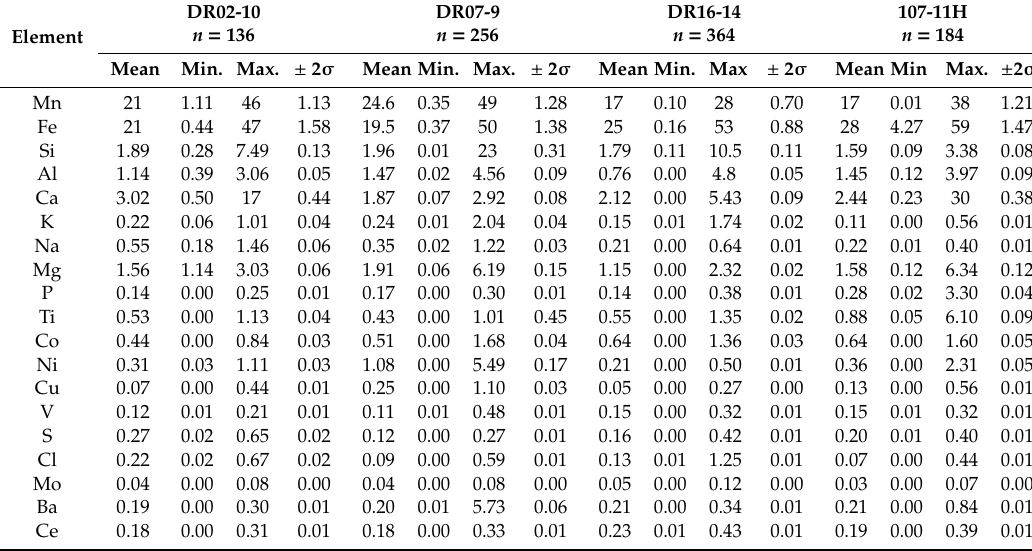
Table 4. Average chemical composition in wt. % obtained with EPMA of each studied crust, the number of analysis is indicated. Min = minimum, Max = maximum, ± 2 σ = 95% confidence. DR02-10 DR07-9 DR16-14 n = 136 n = 256 n = Element